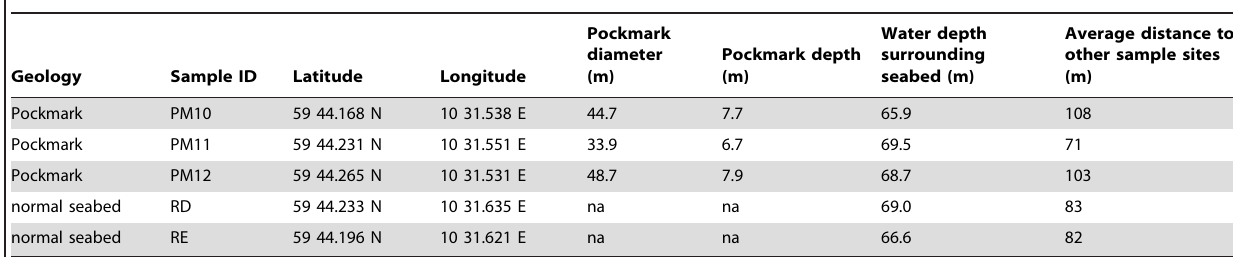
Table 1. Description of Oslofjord sampling